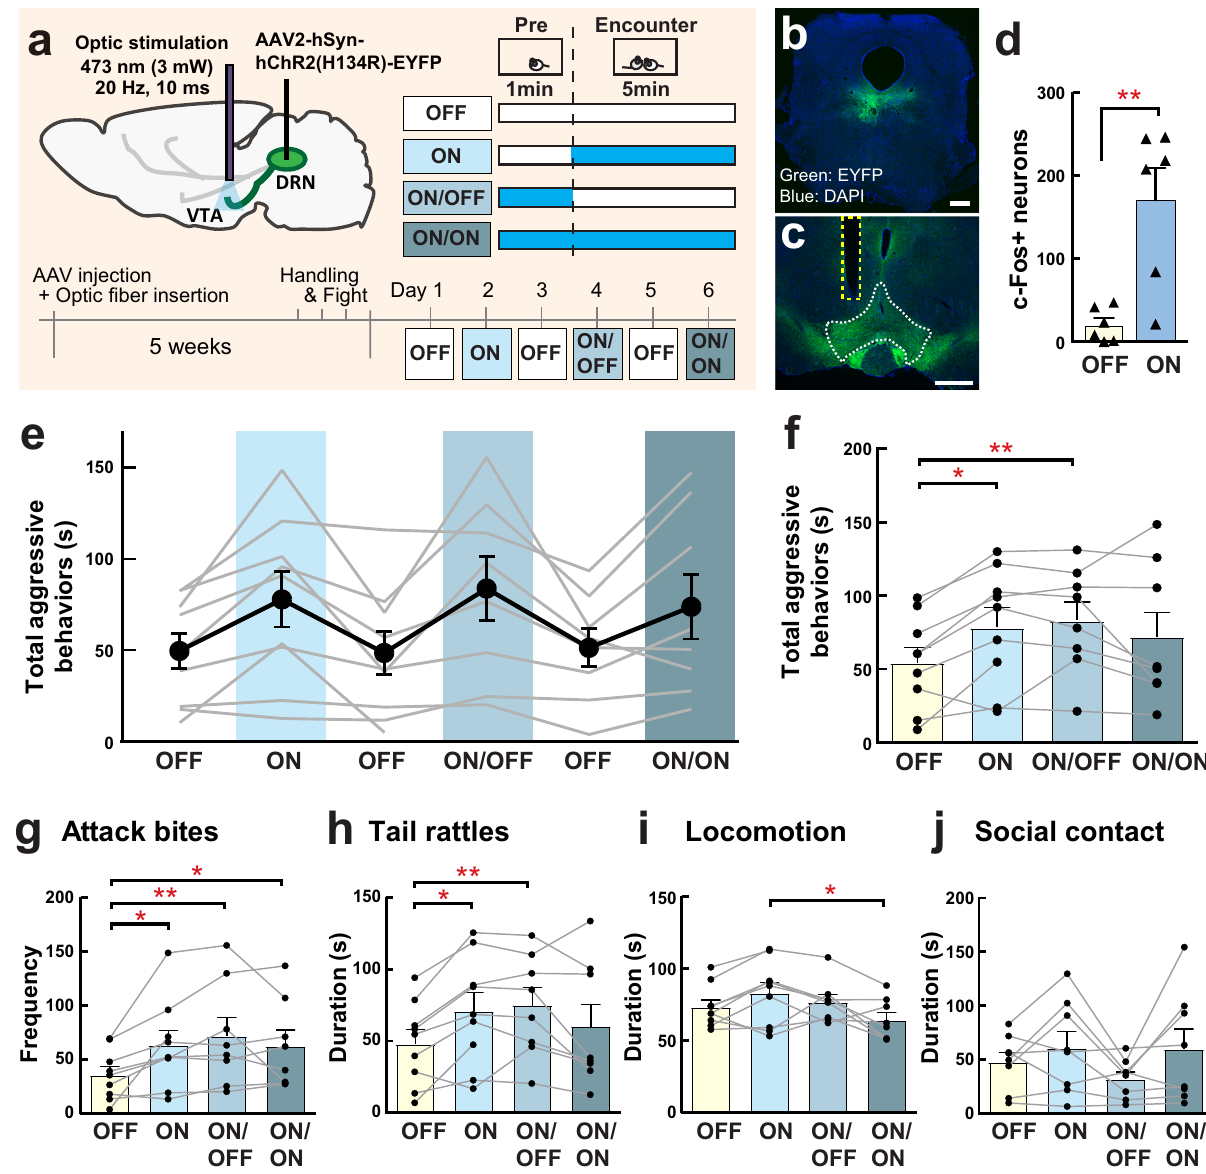
Fig. 8 Optogenetic activation of DRN-VTA projection neurons increases aggressive behavior. a Schematics and timeline of this experiment. AAV2- hSyn-ChR2-EYFP was injected into the DRN, and the optic fi ber was inserted into the VTA. Stimulation schematics were same as in Fig. 5. Expression of ChR2-EYFP (green) in the DRN ( b scale bar 500 μ m) and their projections in the VTA ( c scale bar 500 μ m). Blue: DAPI. d Light stimulation increased c-Fos expression in the VTA after 1 min light stimulation (unpaired t test (two-sided), OFF n = 6, ON n = 6 biologically independent animals, t (10) = 3.796, p = 0.0035). e Duration of total aggressive behaviors in each session. Black line indicates average data of 9 animals (Mean±SEM), and gray line indicates each individual ’ s data. f Summarized data for the duration of total aggressive behavior in each condition. Value of OFF session was calculated as average data from Day 1, 3, and 5. Both ON and ON/OFF sessions showed signi fi cantly longer duration of aggressive behavior compared to the OFF session (mixed- effects analysis (two-sided), n = 9 biologically independent animals, F(1.977,14.50) = 5.133, p = 0.0209, post hoc t test with Tukey ’ s multiple comparisons test (two-sided)). Detailed behavioral analysis showed that all stimulation schematics (ON, ON/OFF, ON/ON) increased attack bites compared to OFF session ( g mixed-effects analysis (two-sided), n = 9 biologically independent animals, F (3,22) = 6.268, p = 0.0031, post hoc t test with Tukey ’ s multiple comparisons test (two-sided)), whereas only ON and ON/OFF sessions showed signi fi cant increases in the duration of tail rattles compared to OFF session ( h mixed-effects analysis (two-sided), n = 9 biologically independent animals, F (1.949,14.30) = 5.669, p = 0.0159, post hoc t test with Tukey ’ s multiple comparisons test (two-sided)). By contrast, ON/ON session showed a signi fi cant reduction of locomotion compared to ON session ( i ; mixed- effects analysis (two-sided), n = 9 biologically independent animals, F(1.977,14.50) = 5.133, p = 0.0209, post hoc t test with Tukey ’ s multiple comparisons test (two-sided)). No effect of light stimulation was observed in social contact ( j Friedman test (two-sided), n = 9 biologically independent animals, n.s.). Each bar represents mean value ± SEM, and gray line indicates each individual ’ s data. * p < .05, ** p < .01. Source data are provided as a Source Data fi